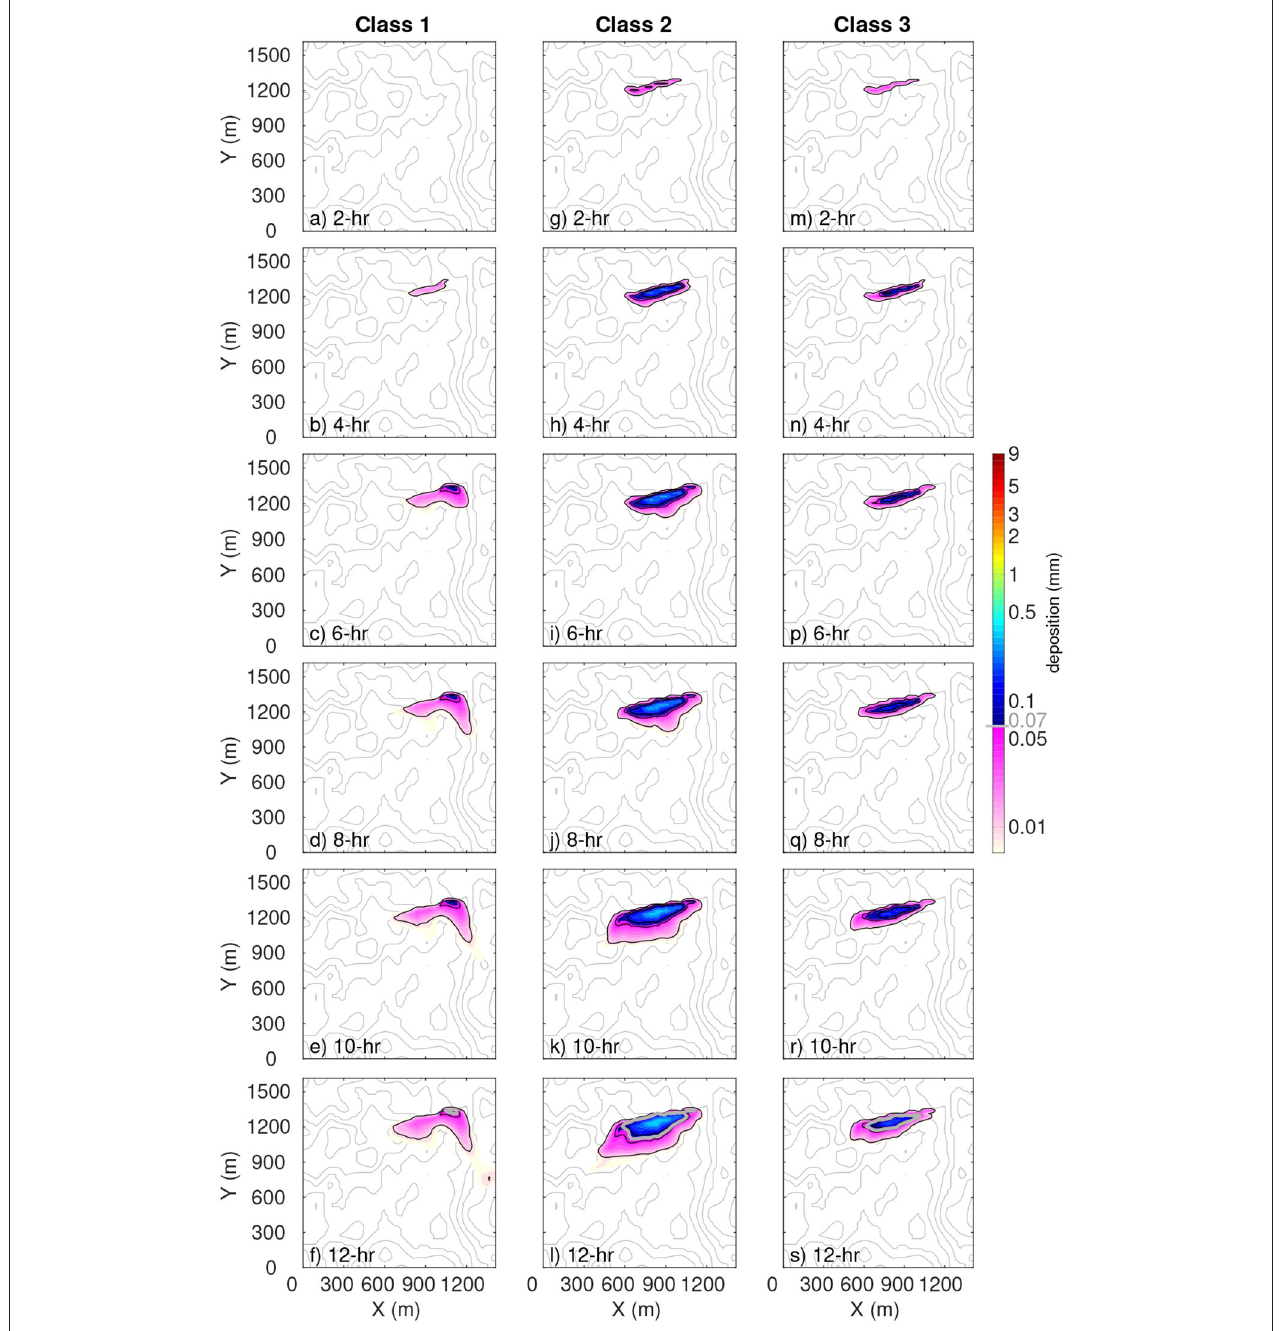
FIGURE 6 | Sediment redeposition patterns at (a) 2-h, (b) 4-h, (c) 6-h, (d) 8-h, (e) 10 h, and (f) 12 h after dredging for particle size class1. (g–s) Redeposition of particle size class 2 and class 3, respectively, for same time steps as presented for particle size class1. The colourbar shows sediment thickness ranging from 0.01 to 9 mm in logarithmic scale. Thin grey lines in the background show the seafloor topography. The 0.07 mm deposition thickness shown as thick grey contour marks the boundary between near- and far-field areas. The near- and far-field areas are customised in the colourbar with different colour scale.